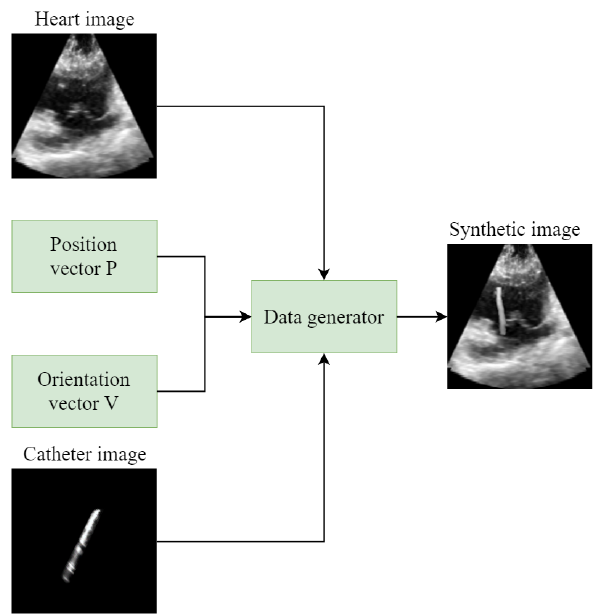
Figure 3. Scheme of the synthetic data generator 4 inputs and is shown in Fig. 3. It is worth adding that a pair of vectors ( P, V ) sets the position and orientation of the catheter in a new blank image.